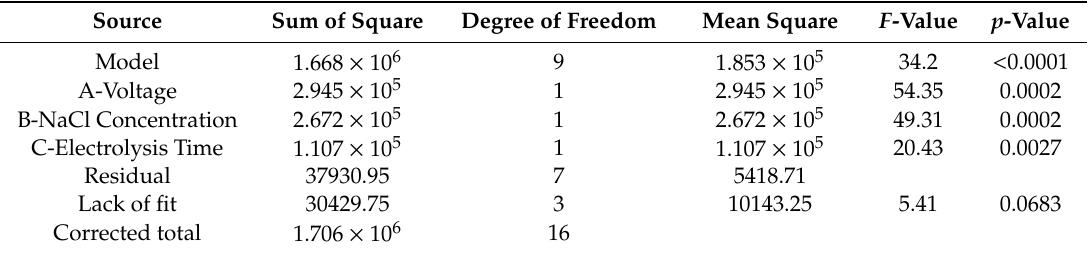
Table9. Analysisofvarianceforthedevelopedresponsesurfacequadraticmodelforoxidation-reduction potential (ORP) of AcEW.